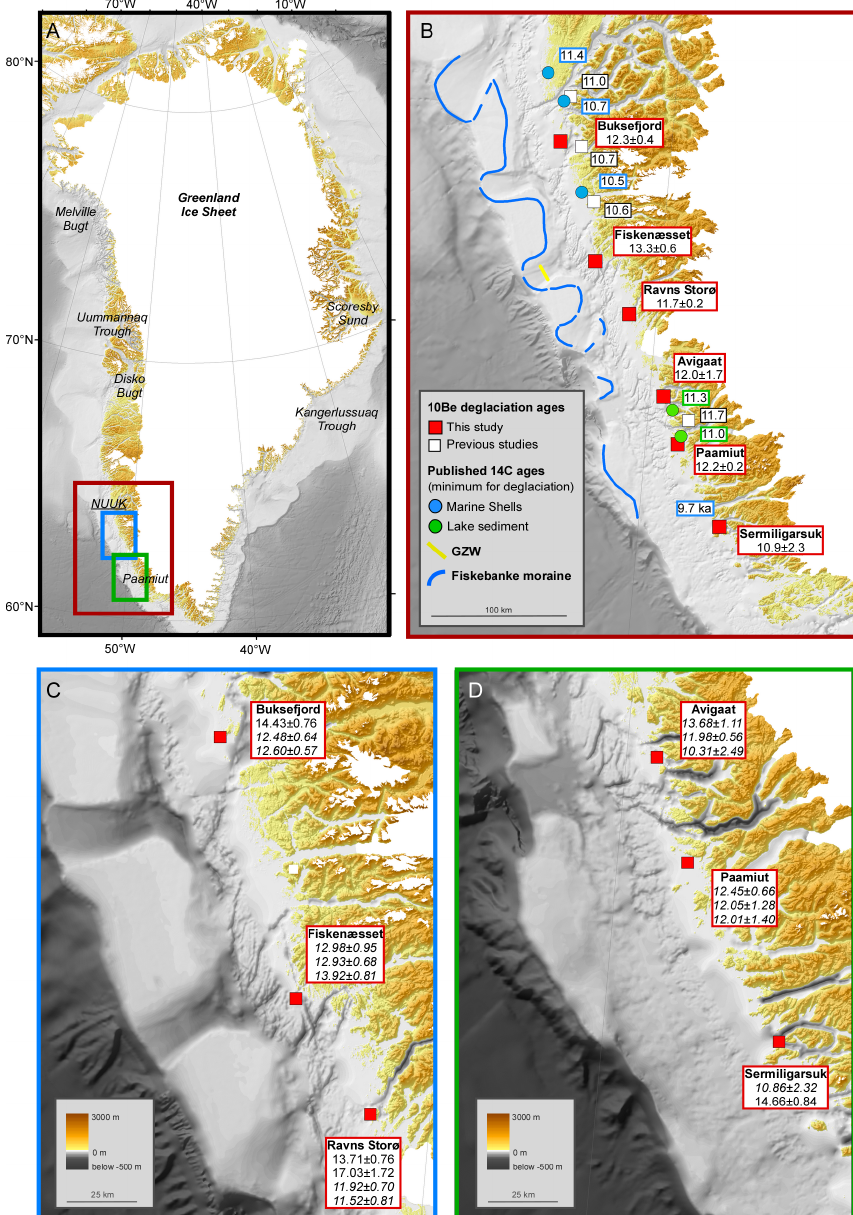
Figure 1. Location of the study area (a) . Estimated deglaciation ages and 14 C minimum constraints from this work and previous studies (b) . Details of the cosmogenic dates from this work and shelf bathymetry (c, d) . For references to previous results, see the text. The background map of Greenland and surrounding seas is from BedMachine Greenland v.3 (Morlighem et al.,